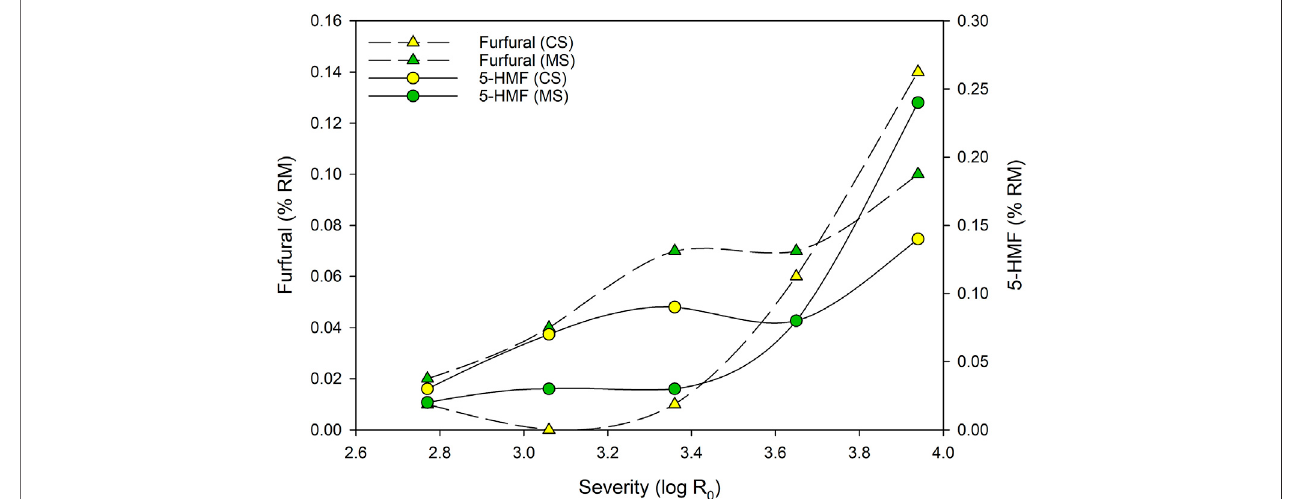
FIGURE 4 | Effect of steaming severity on the concentration of furan derivatives (furfural and 5-HMF) in the fi ltrates obtained from CS and MS.